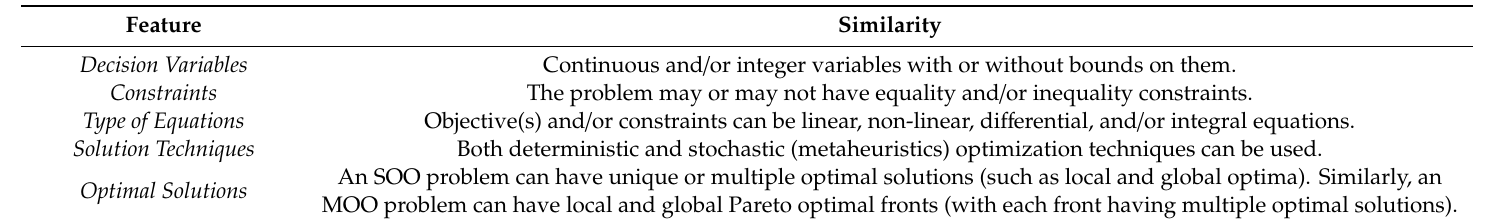
Table 5. Similarities between SOO and MOO.